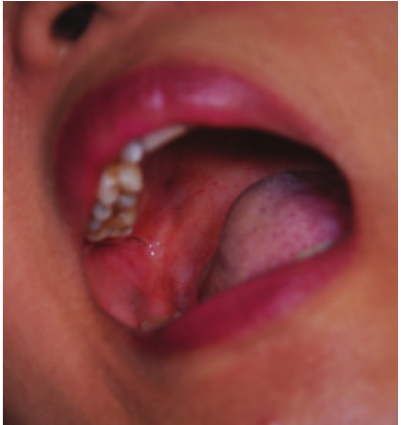
Figure 3: The previously ulcerated oral mucosa healed after 5 days of treatment with tetracycline